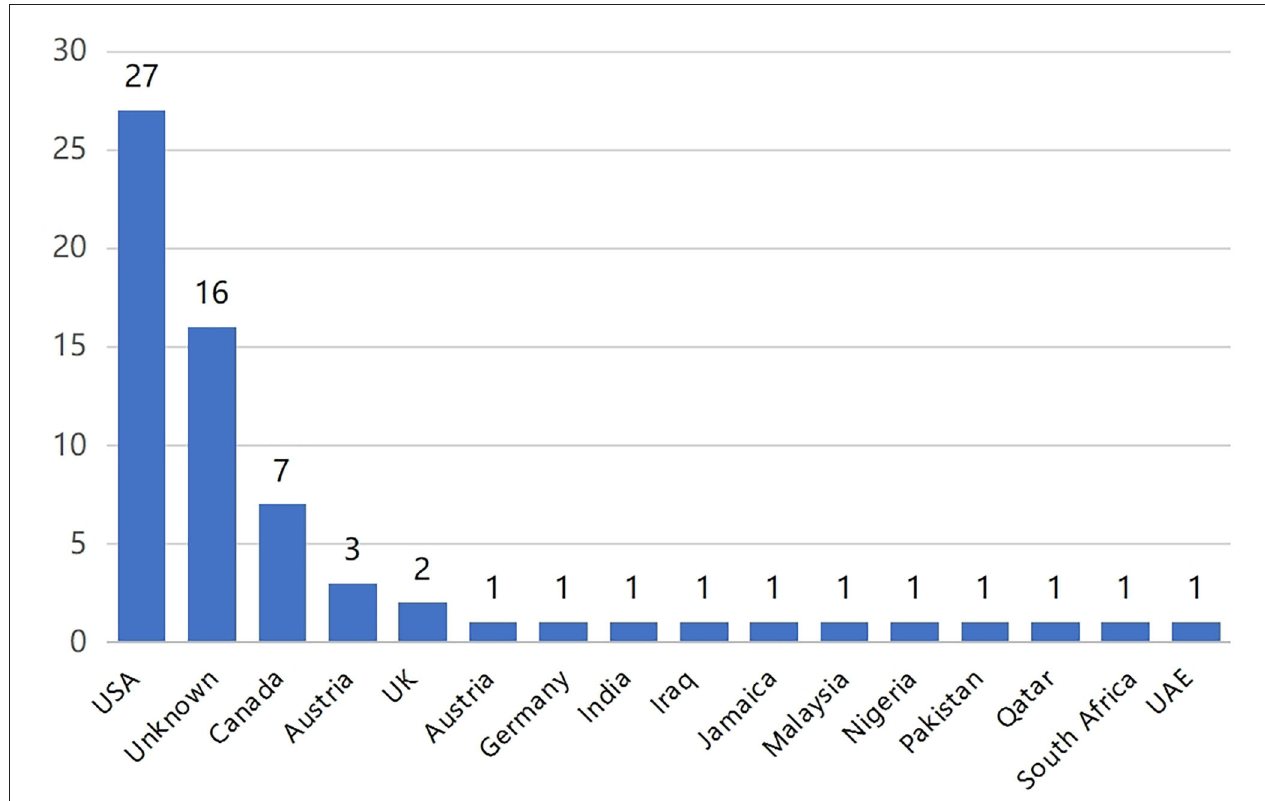
FIGURE 2 | Distribution of authors’ countries of YouTube